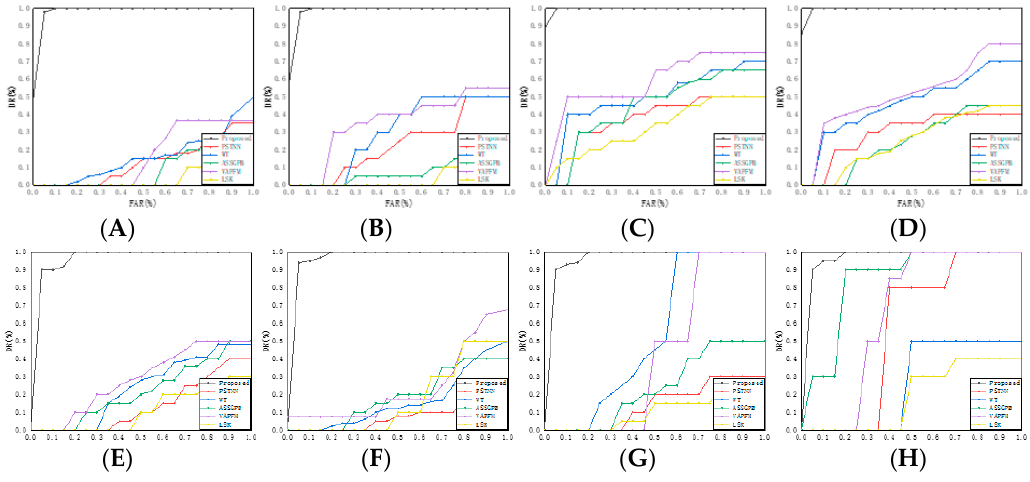
Figure 14. ROC curves of the six methods on datasets ( A – H ),